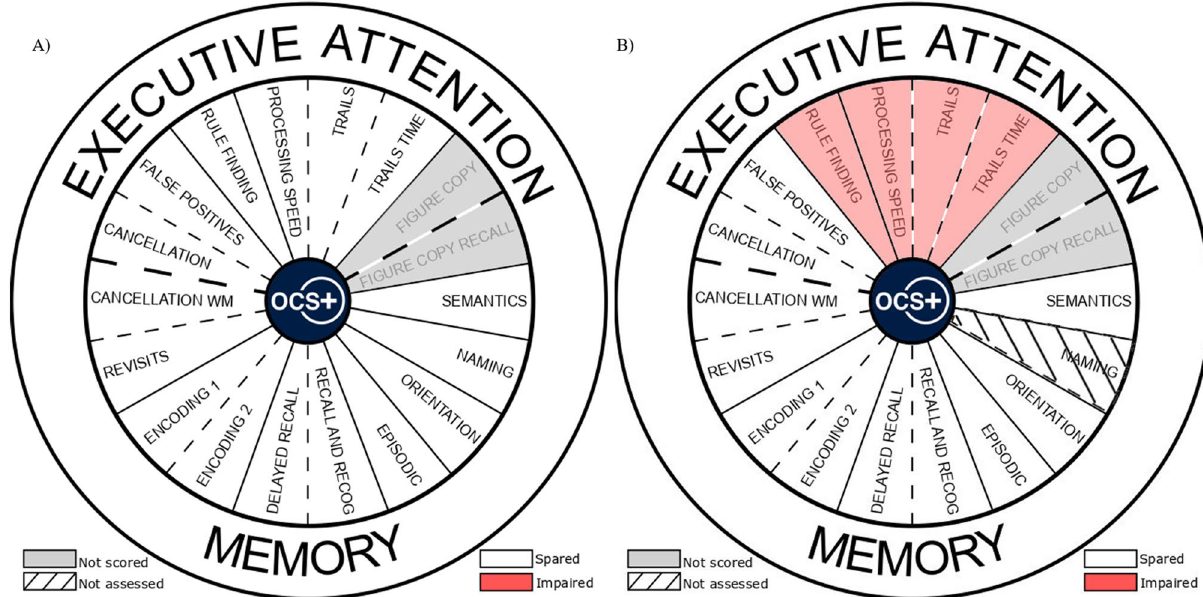
Figure 1. Part ( A ) represents the base report outcome wheel from the Oxford Cognitive Screen-Plus which is edited depending on performance of the participants (i.e., impaired or spared compared to norms), and ( B ) Represents a mockup of a patient who was impaired in the Trails and Rule Finding tasks compared to age matched normative data and who was not assessed with the picture naming task. Figure Copy and Figure Copy Recall are grey due to not currently having automatic scoring implemented in the app. Figure created in Inkscape (version 1.0.2, https:// inksc ape. org/) available at https:// osf. io/ ajzht/ under a CC-BY4.0